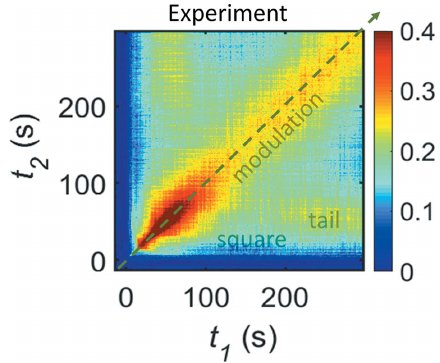
Figure 1 Experimental TTC for the BSA—YCl 3 sample undergoing LLPS. XPCS measurement was performed for a temperature jump from 10 to 40 (cid:2) C with a total measuring time of 312 s. The TTC is for q = 4.4 m m (cid:3) 1 . The square, tail and modulation features are marked with half-transparent text. The green dashed line shows a direction of increase of experimental time t age